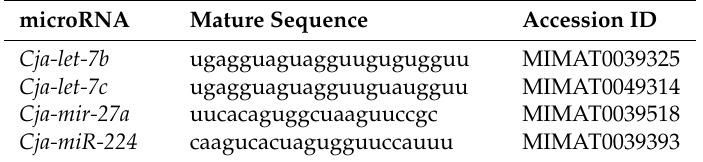
Table 2. miRNAs specific primer sequences for single-cell profiling of marmoset